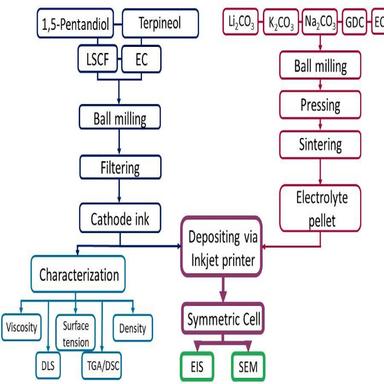
Fabrication and characterization procedure flowchart of inkjet-printed LSCF symmetric cell.